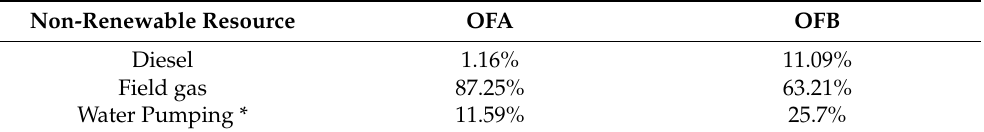
Table 8. Contribution analysis of non-renewable resources expressed as a percentage of the overall carbon footprint produced in a geothermal energy co-generation system.